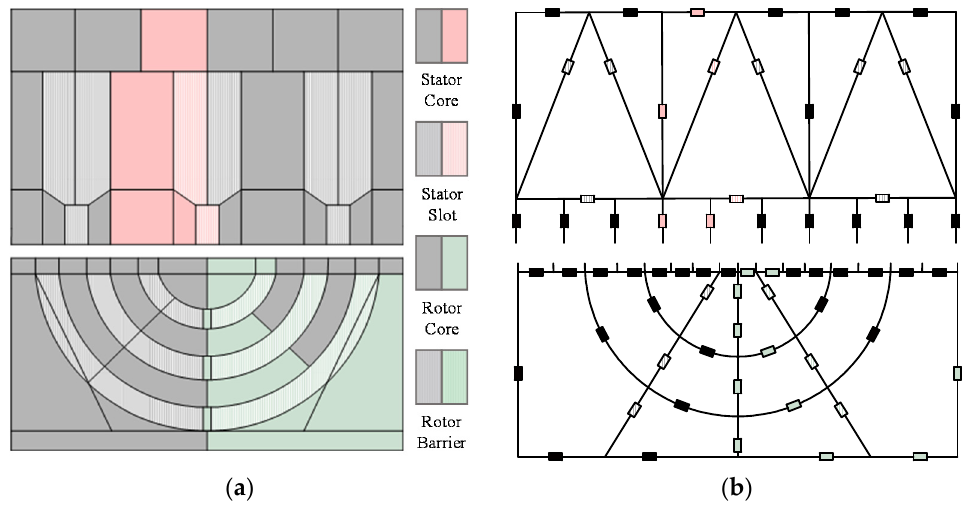
Figure 2. MEC model for a quarter of 12/4 SynRM. ( a ) 1/4 topology, ( b ) 1/4 MEC model.